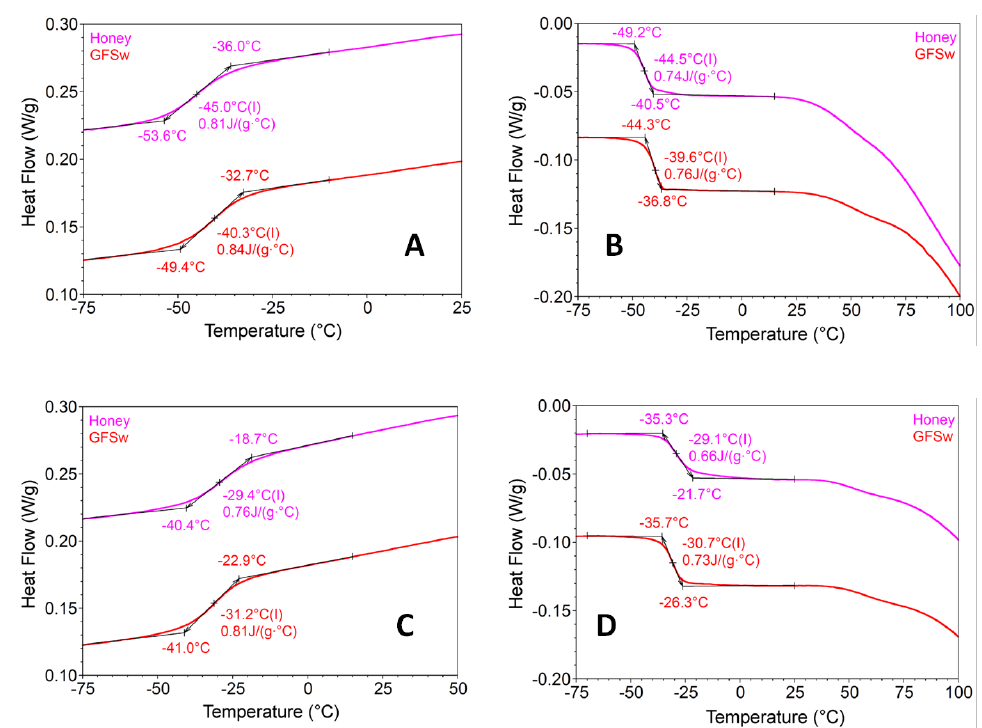
Figure 6. Differential scanning calorimetry (DSC) heating thermograms of honey and GFSw. First cooling cycle in the range of temperatures from 0 °C to − 75 °C ( A ), first heating cycle in the range of temperatures from − 75°C to 100 °C ( B ), second cooling cycle in the range of temperatures from 0 °C to − 75 °C ( C ), second heating cycle in the range of temperatures from − 80 °C to 100 °C ( D ). The corresponding enthalpy was 235.5 J/g for honey and 243.5 J/g for GFSw. This transition occurs when the material changes upon cooling from the rubber-like state into the hard, glassy state [39]. The first heating from − 75 ◦ C to 100 ◦ C presented similar reversible transitions, but with less negative temperatures and lower heat capacities, representing transitions from the glassy solid state to the rubbery state upon heating. There was also a change in heat flow at high temperatures (>25 ◦ C), steeper and larger for honey than for